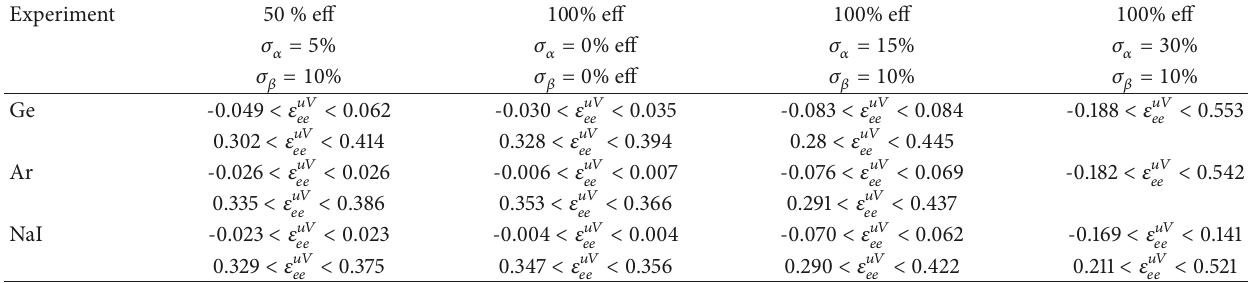
Table 4: Expected sensitivity to the nonuniversal NSI parameter 𝜀 𝑢𝑉 𝑒𝑒 . For each experiment we quote the 90 % CL expected sensitivity for the different scenarios that we have